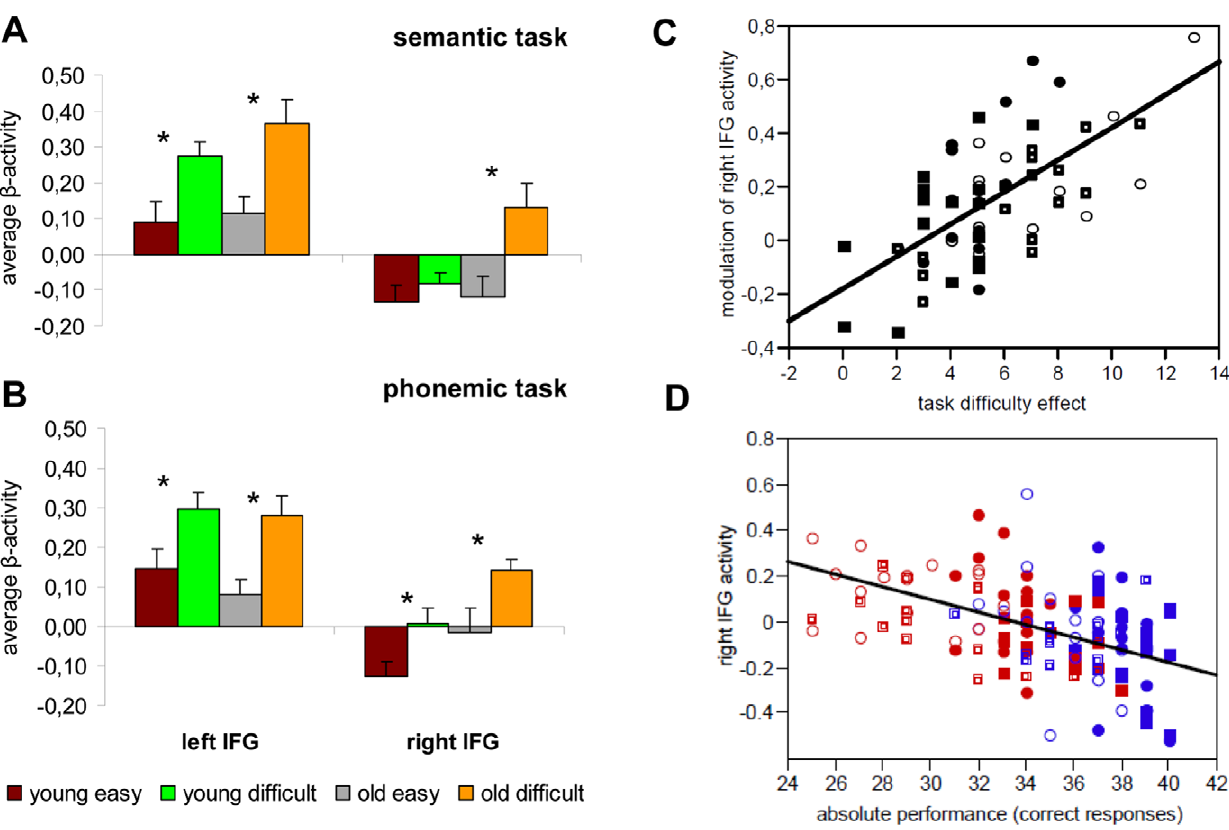
Figure 3. Region of interest analysis. Illustrates the modulation of activity bilaterally in vIFG clusters by task difficulty during the (A) semantic and (B) phonemic task for age-group (young vs. old) and hemisphere (left vs. right). Stars indicate difficulty comparisons that are significant at the various levels of TASK, AGE-GROUP, and HEMISPHERE. (C) Positive correlation of individual task difficulty (difficult - easy) with modulation of individual activity levels in the right vIFG (difficult - easy). (D) Negative correlation of right vIFG activity with absolute performance accuracy across age-groups, fluency tasks, and difficulty conditions [easy conditions=blue; difficult conditions=red; circles=older group; squares=younger group; solid=semantic fluency, open=phonemic fluency].